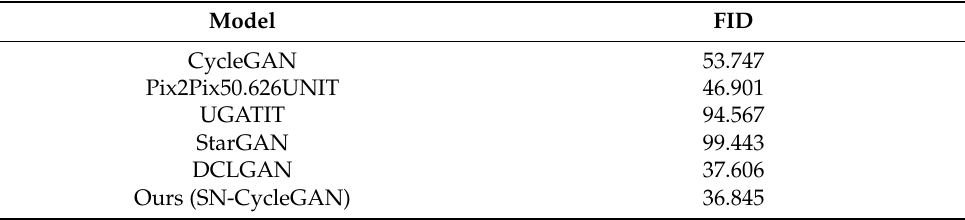
Table 4. Image translation quantification results for different